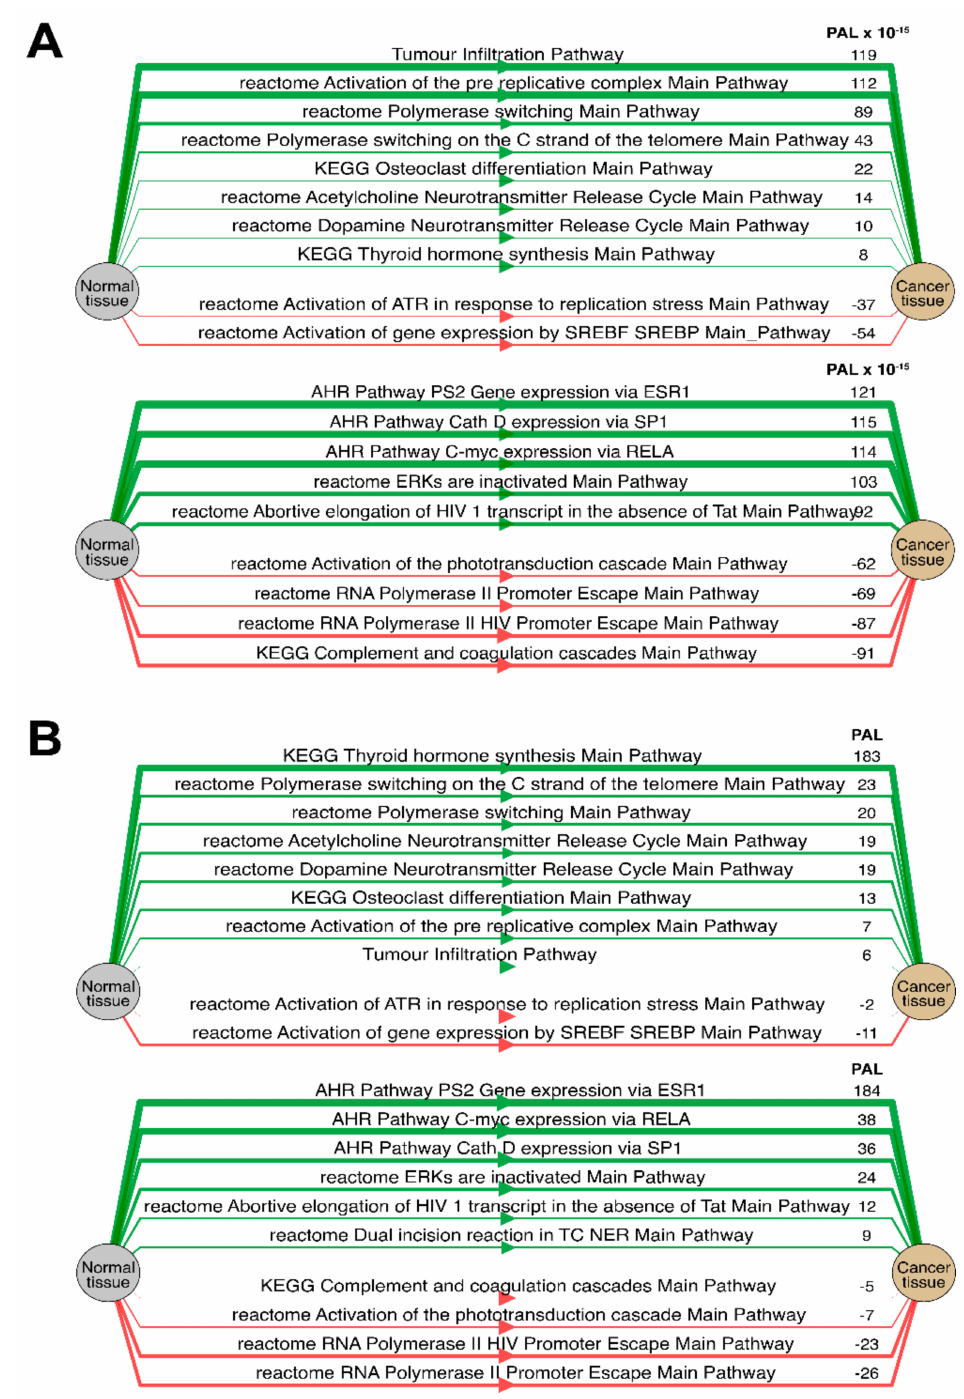
Figure 14. Diagram of activation (green) and inhibition (red) of top 10 of the most ( top ) and the least ( bottom ) correlated molecular pathways between RNA and protein expression for Lung Adeno- carcinoma biosamples. Pathway activation level (PAL) independently estimated based on ( A ) protein levels and ( B ) RNA